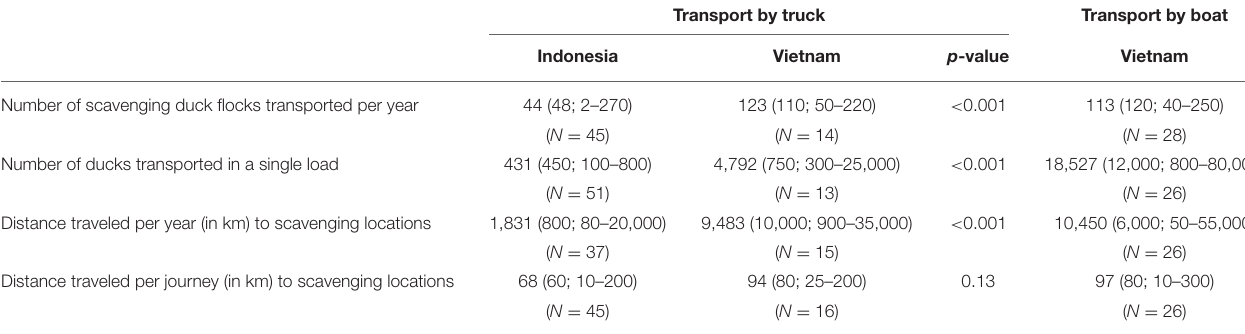
TABLE 1 | Volume of transport and distance traveled by transporters of moving duck flocks in Indonesia. Transport by truck Transport by boat Indonesia Vietnam p -value